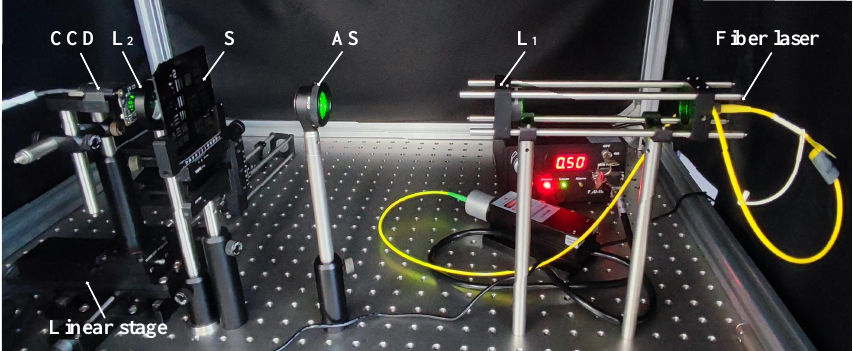
Figure 8. The schematic diagram of the CDI setup.